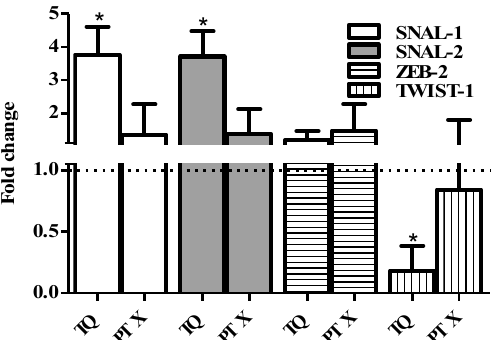
Figure 7. Effect of PTX and TQ on the expression of EMT-related genes in MCF-7 cells. Cells were exposed PTX or TQ for 24 h. Total RNA was extracted and subjected to RT-qPCR to measure gene expression. Data were plotted using the 2- ΔΔ Ct method (expression normalized to the housekeeping gene GAPDH). Fold expression and significance was calculated relative to control untreated cells (dotted line). Data are presented as mean ± SD; n = 3. (*) significantly different from the control group.